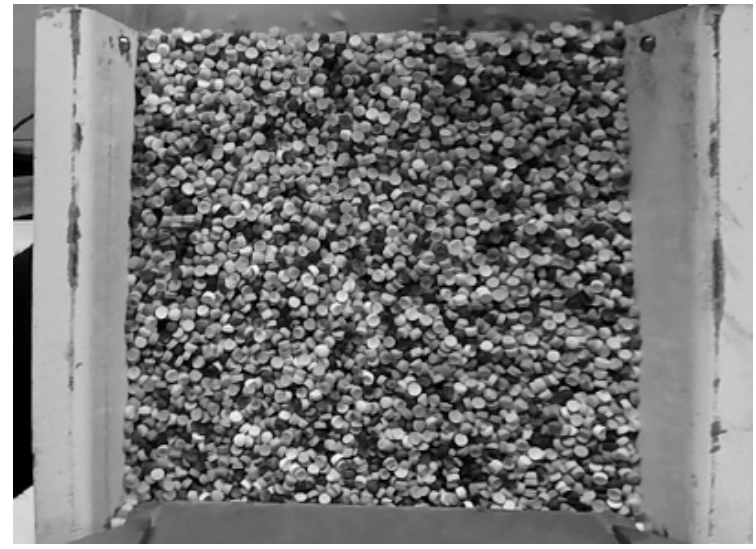
Figure 6. An acquired image for the sediment vibrating channel. Sediment motion is from the bottom to the top of the image.